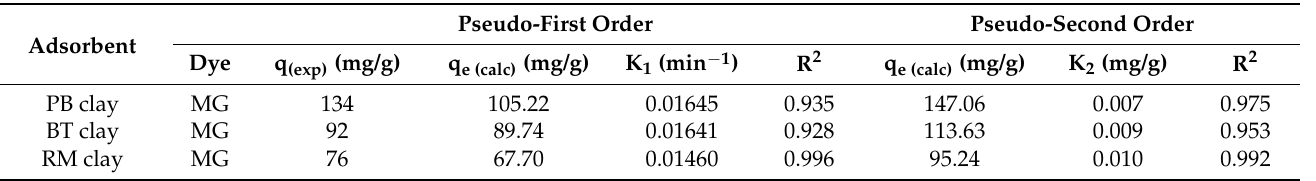
Table 5. Comparison of the maximum adsorption capacities of some adsorbents used for MG dye.